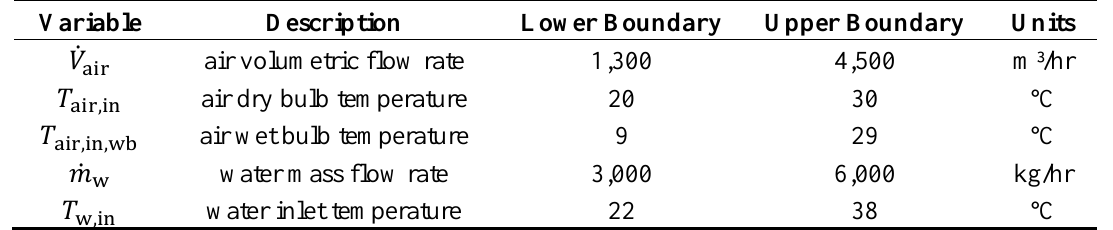
Table 2. Range of input parameters to Type 51 cooling tower model in TRNSYS